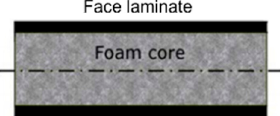
Figure 1. A scheme of a sandwich panel with an external face made by composite laminate and an inner “core”. inner